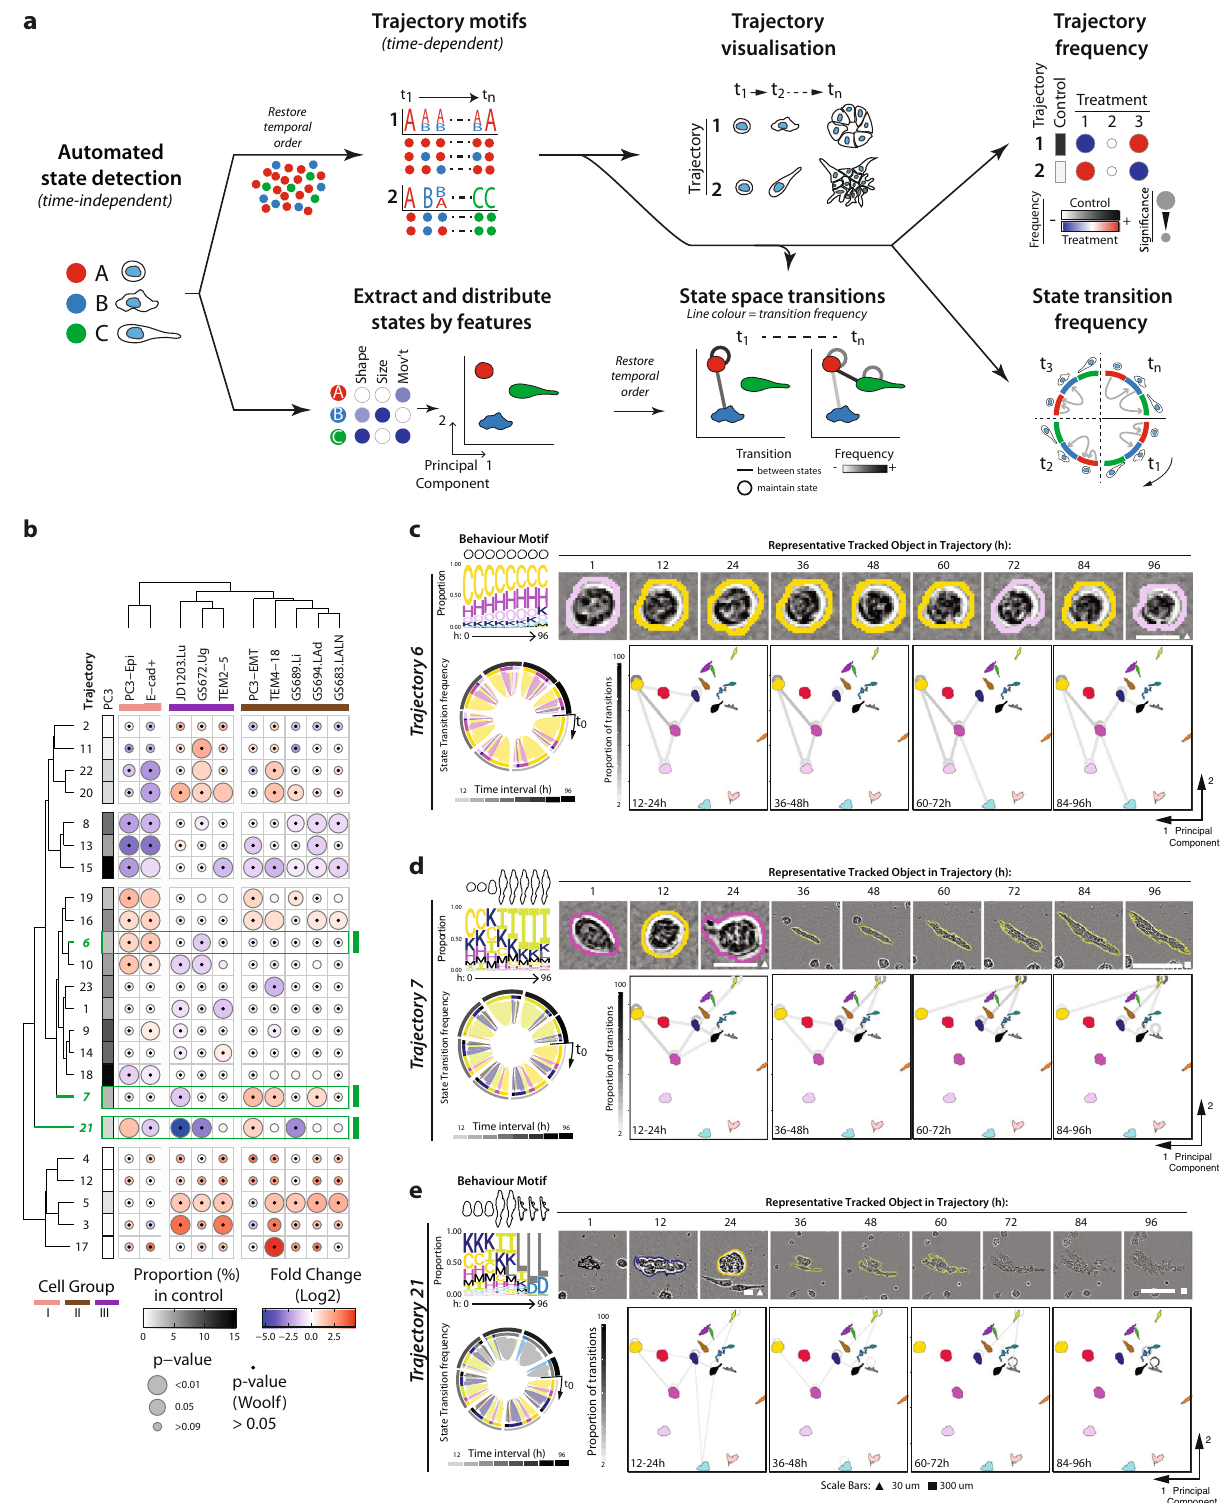
Representative Tracked Object in Trajectory (h):